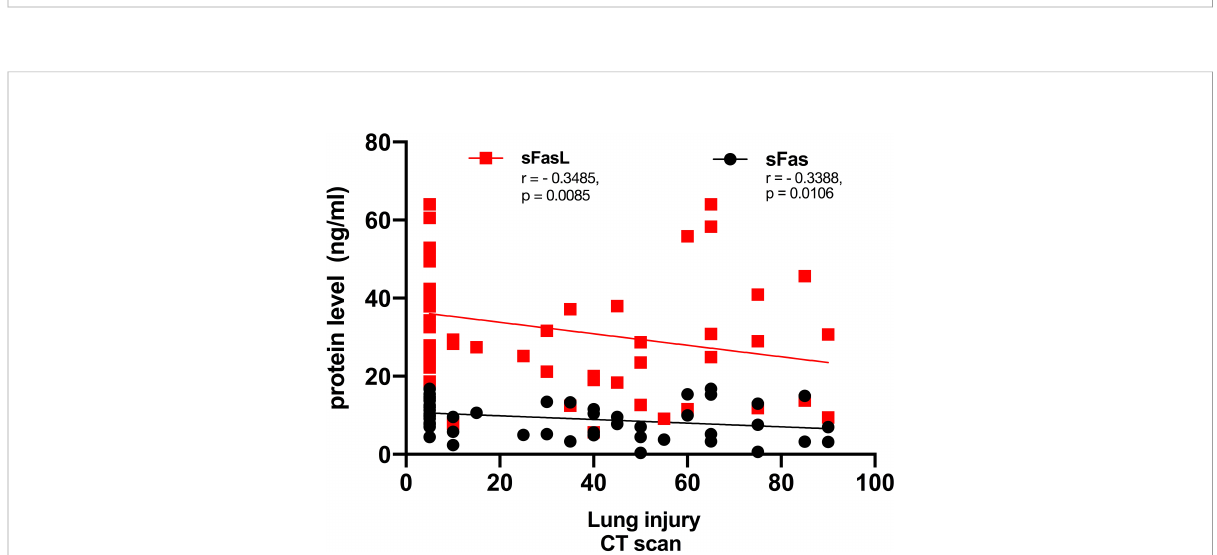
FIGURE 5 Correlation of lung involvement CT scan and sFas/sFasL in COVID-19 patients. Lung has two right and lobes, that includes upper, middle, and lower lobes. Each lobe is about one-sixth of lung area, and percent of involvement is determined by this method in our